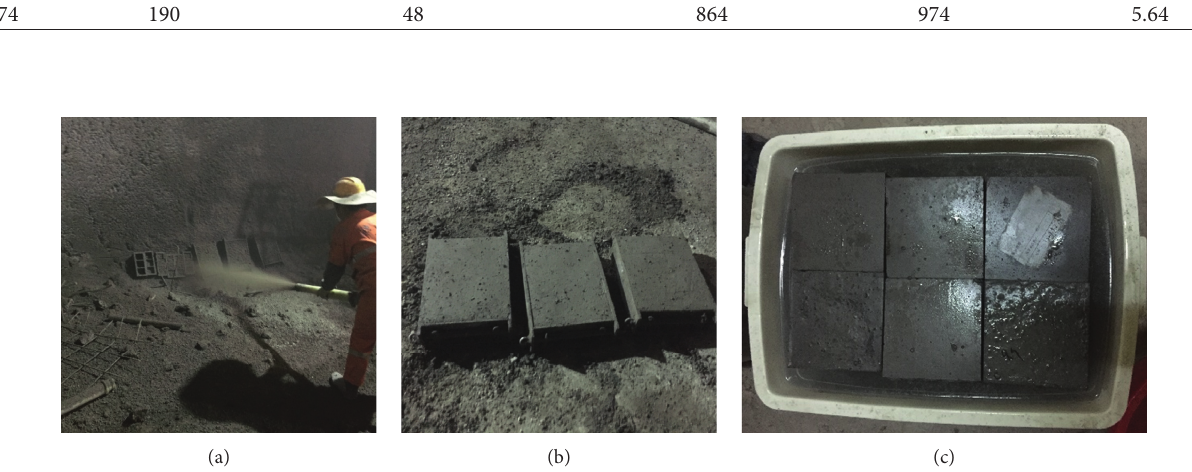
Figure 11: Preparation and maintenance of concrete specimens in tunnel